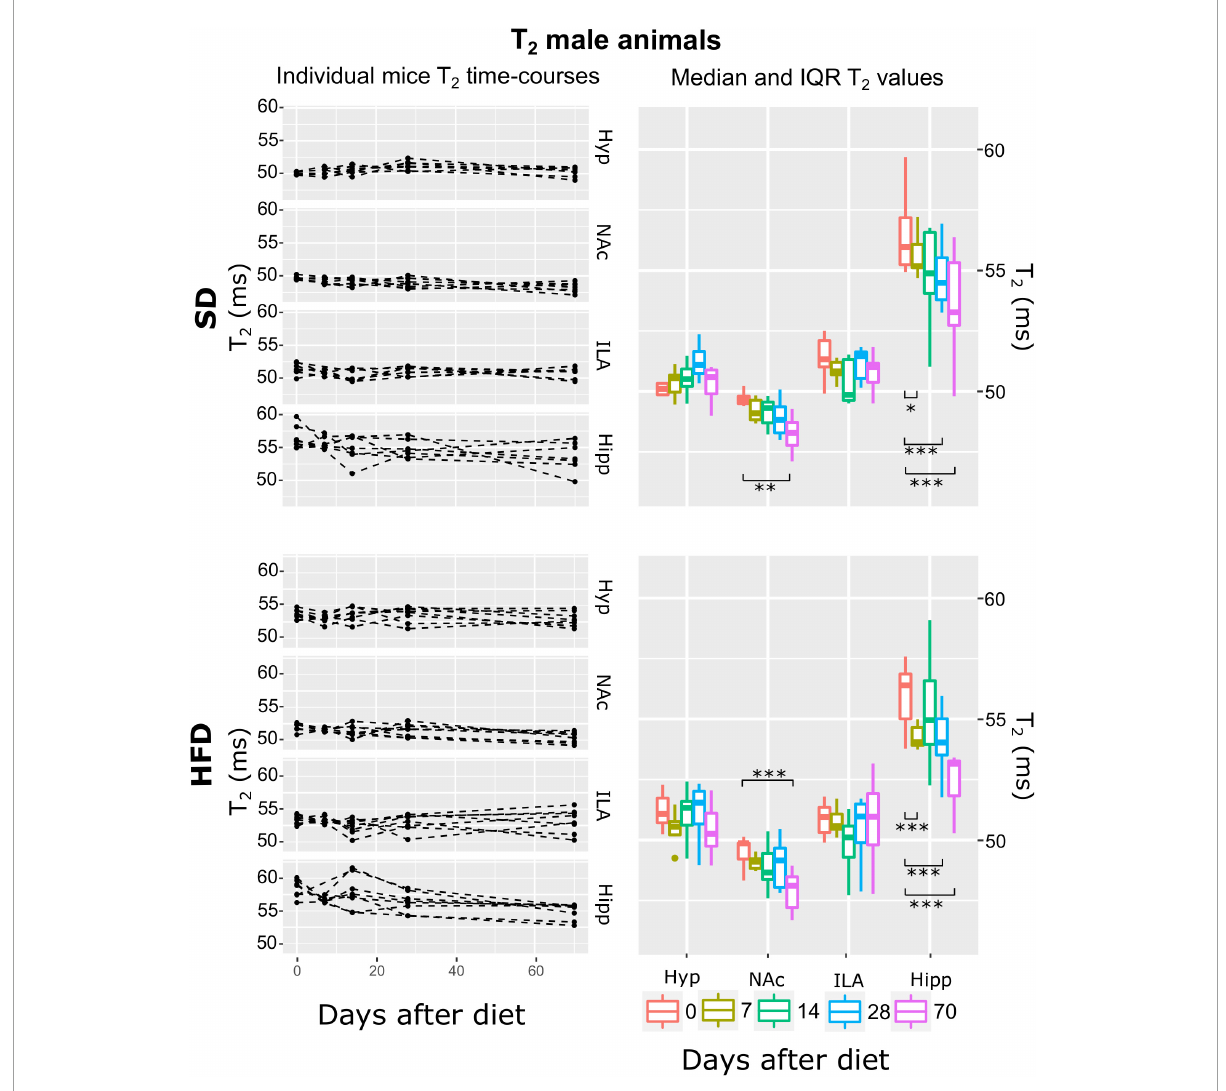
FIGURE5 T2 changes on male mice during HFD or SD consumption. T2 changes on SD-fed (top panels) or HFD (bottom panels) male mice in the four regions investigated: hypothalamus (Hyp), nucleus accumbens (NAc), ipsilateral area (ILA) and hippocampus (Hipp) at all time points measured. Left panels depict the individual T2 regional values at each time point, with dashed lines connecting the adjacent points. Right panels illustrate box plots of T2 vs. time-point for the 4 areas, with each color representing the specific time-point, as days after diet diversification. Note how T2 behaves similarly under both diets, with decreasing values on the NAc and hippocampus (* p < 0.05, ** p < 0.01, *** p < 0.001).